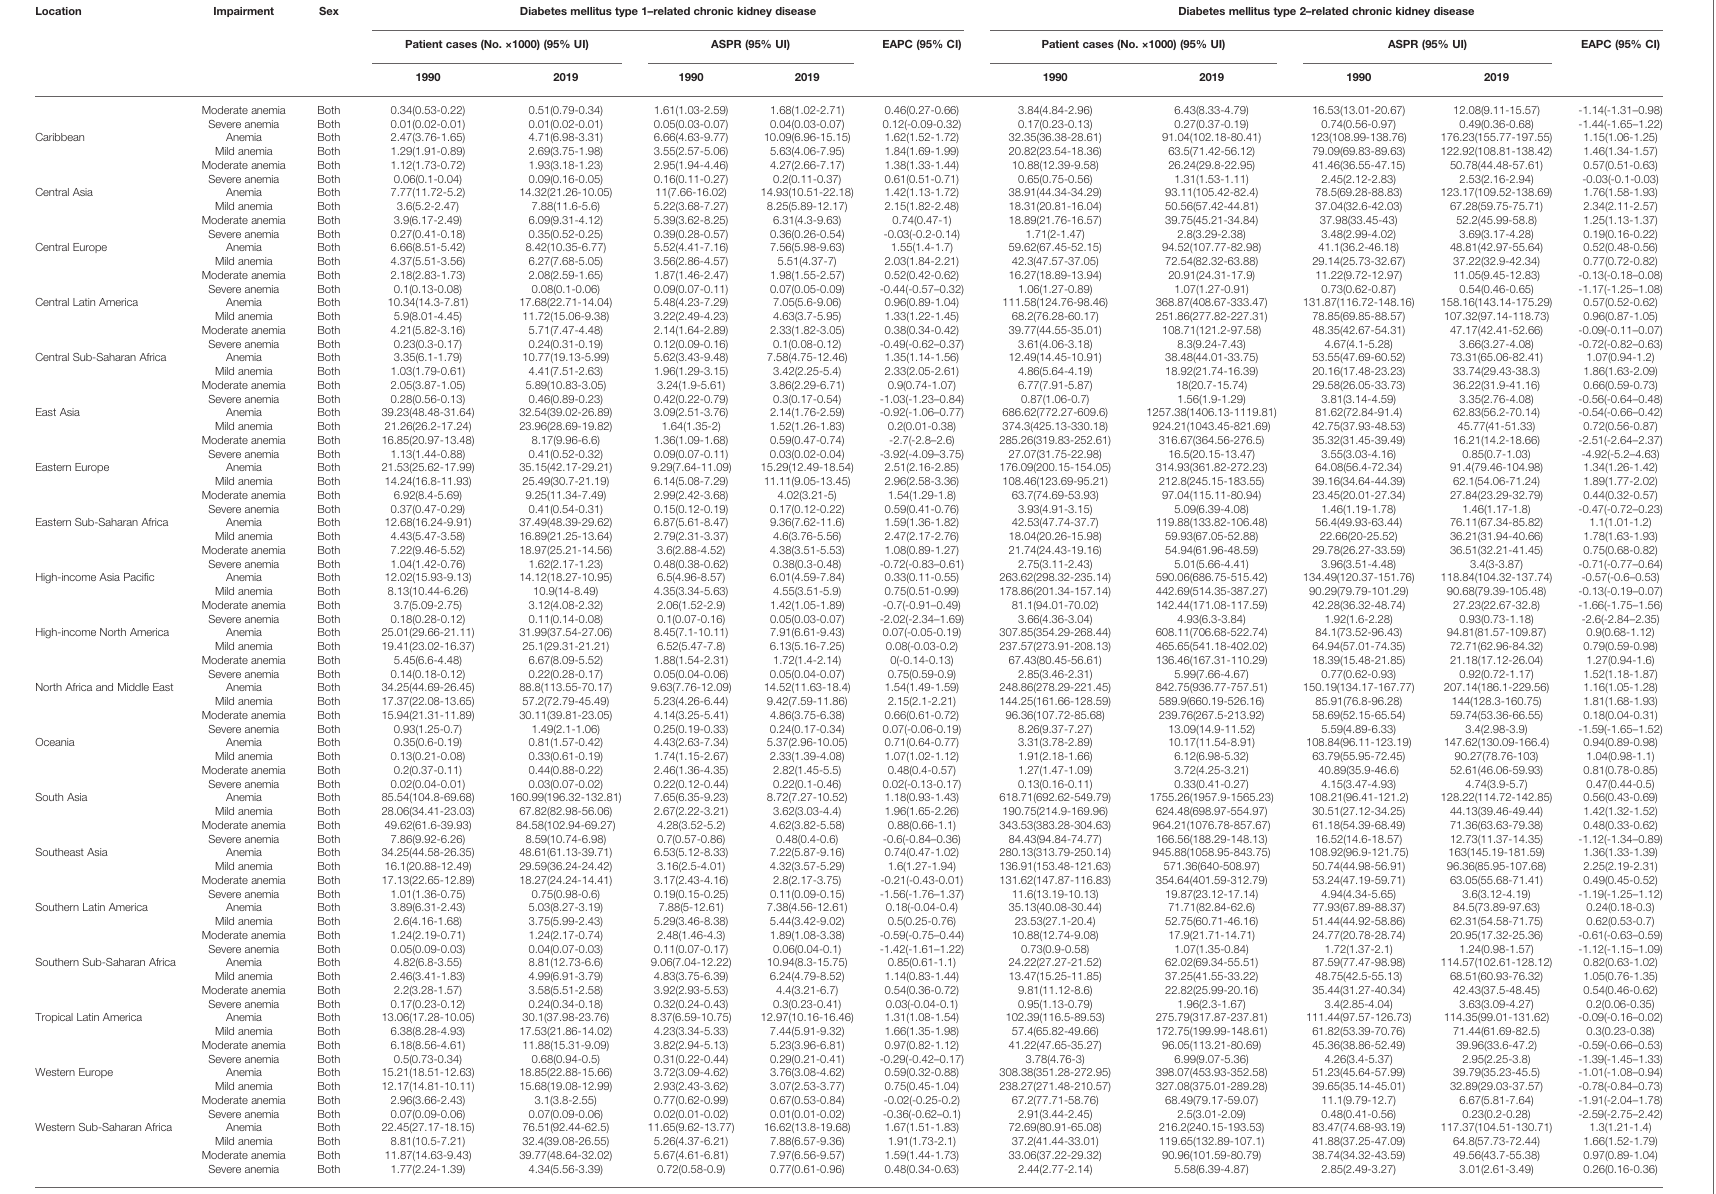
ASPR, age-standardized prevalence rate; EAPC, estimated annual percentage change; UI, uncertainty